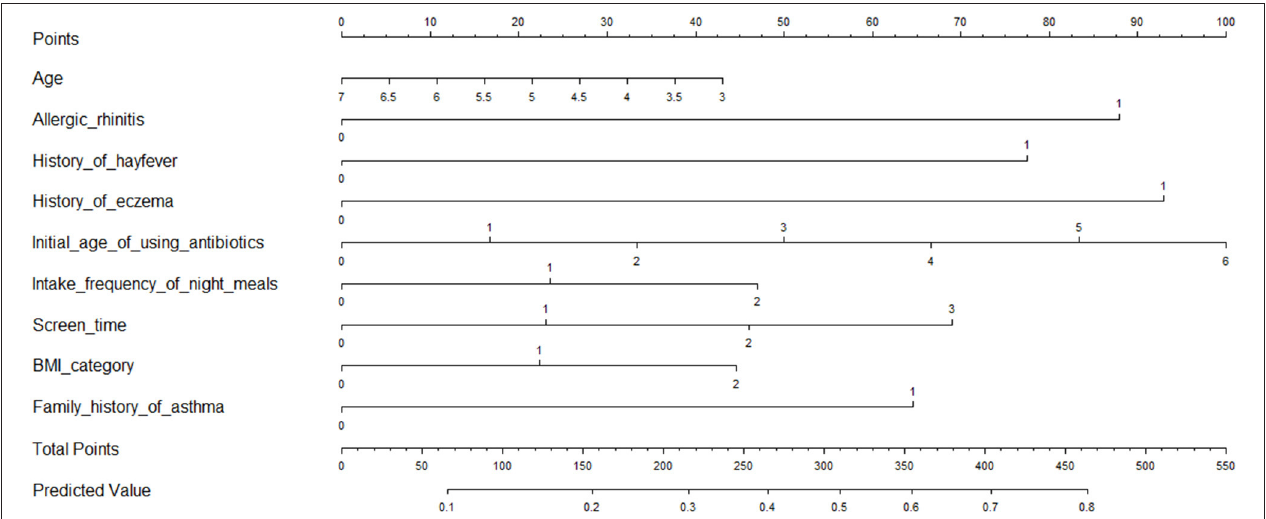
FIGURE 4 | Prediction nomogram for prediction in children with